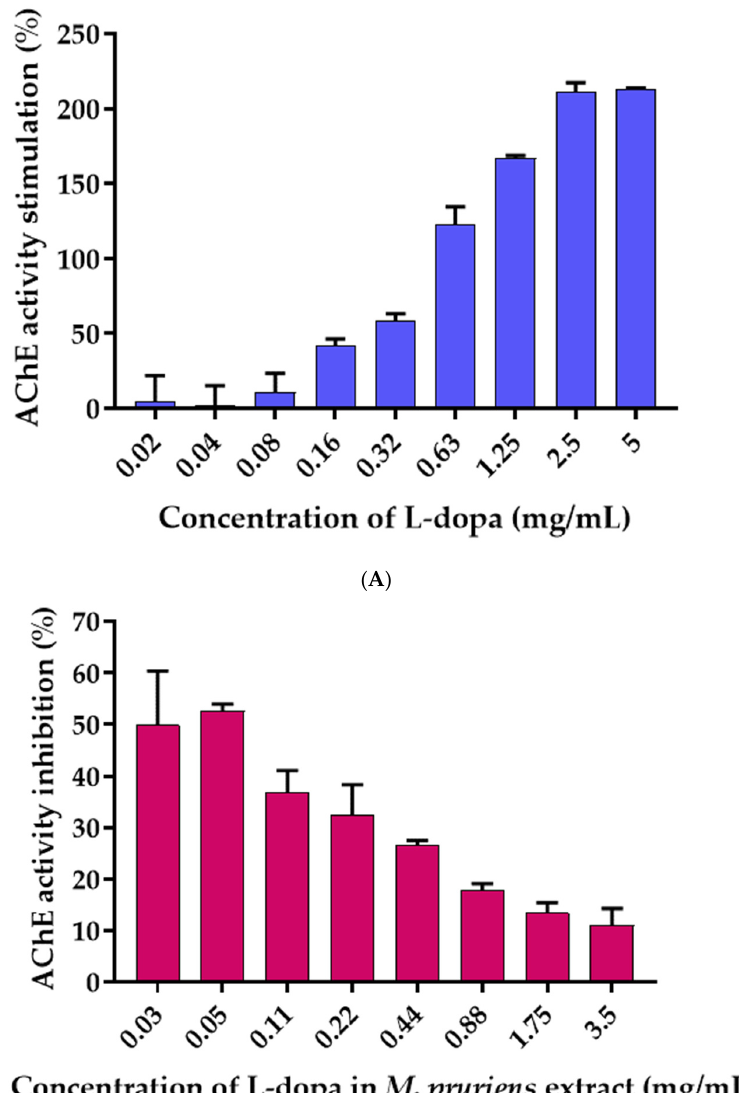
Figure 4. Plots of average O.D. readings subtracted from the mean blank (no enzyme) of each time point from its respective mean sample time points vs. time in the presence of ( A ) L-dopa and ( B ) M. pruriens seed extract.